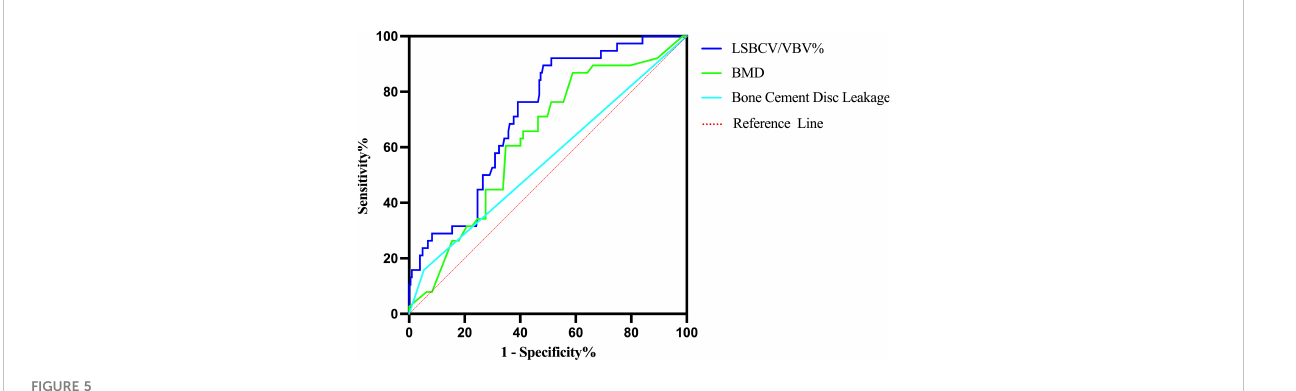
FIGURE 5 ROC curve for the diagnosis of AVCF.